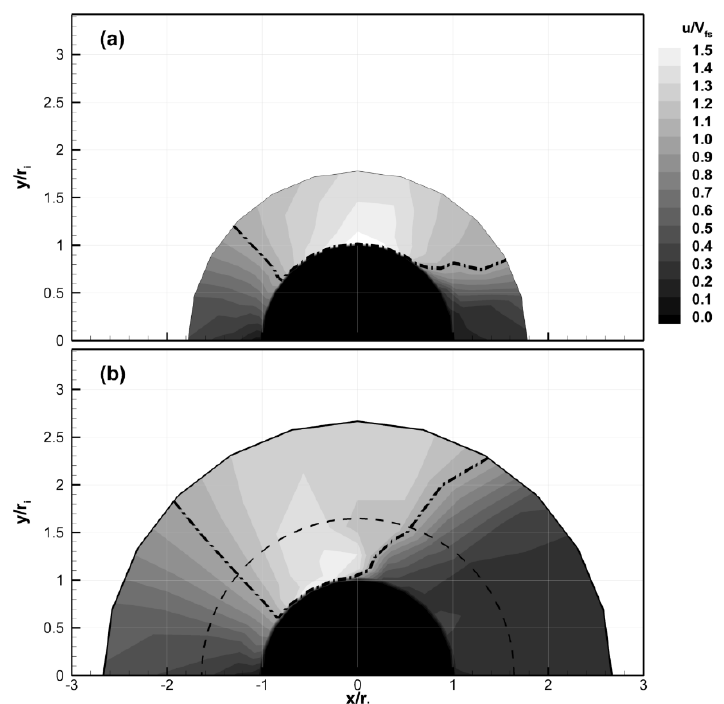
Figure 14. Velocity distribution around the ( a ) smooth and ( b ) and corrugated cylinders. Note: Solid black denotes minor diameter of the corrugated cylinder and the diameter of the smooth cylinder. The dashed line in ( b ) represents the location of the major diameter. The dash-dot-dash line shows the contour of u / V fs = 1. Re = 7.7 × 10 5 . Flow left to right.